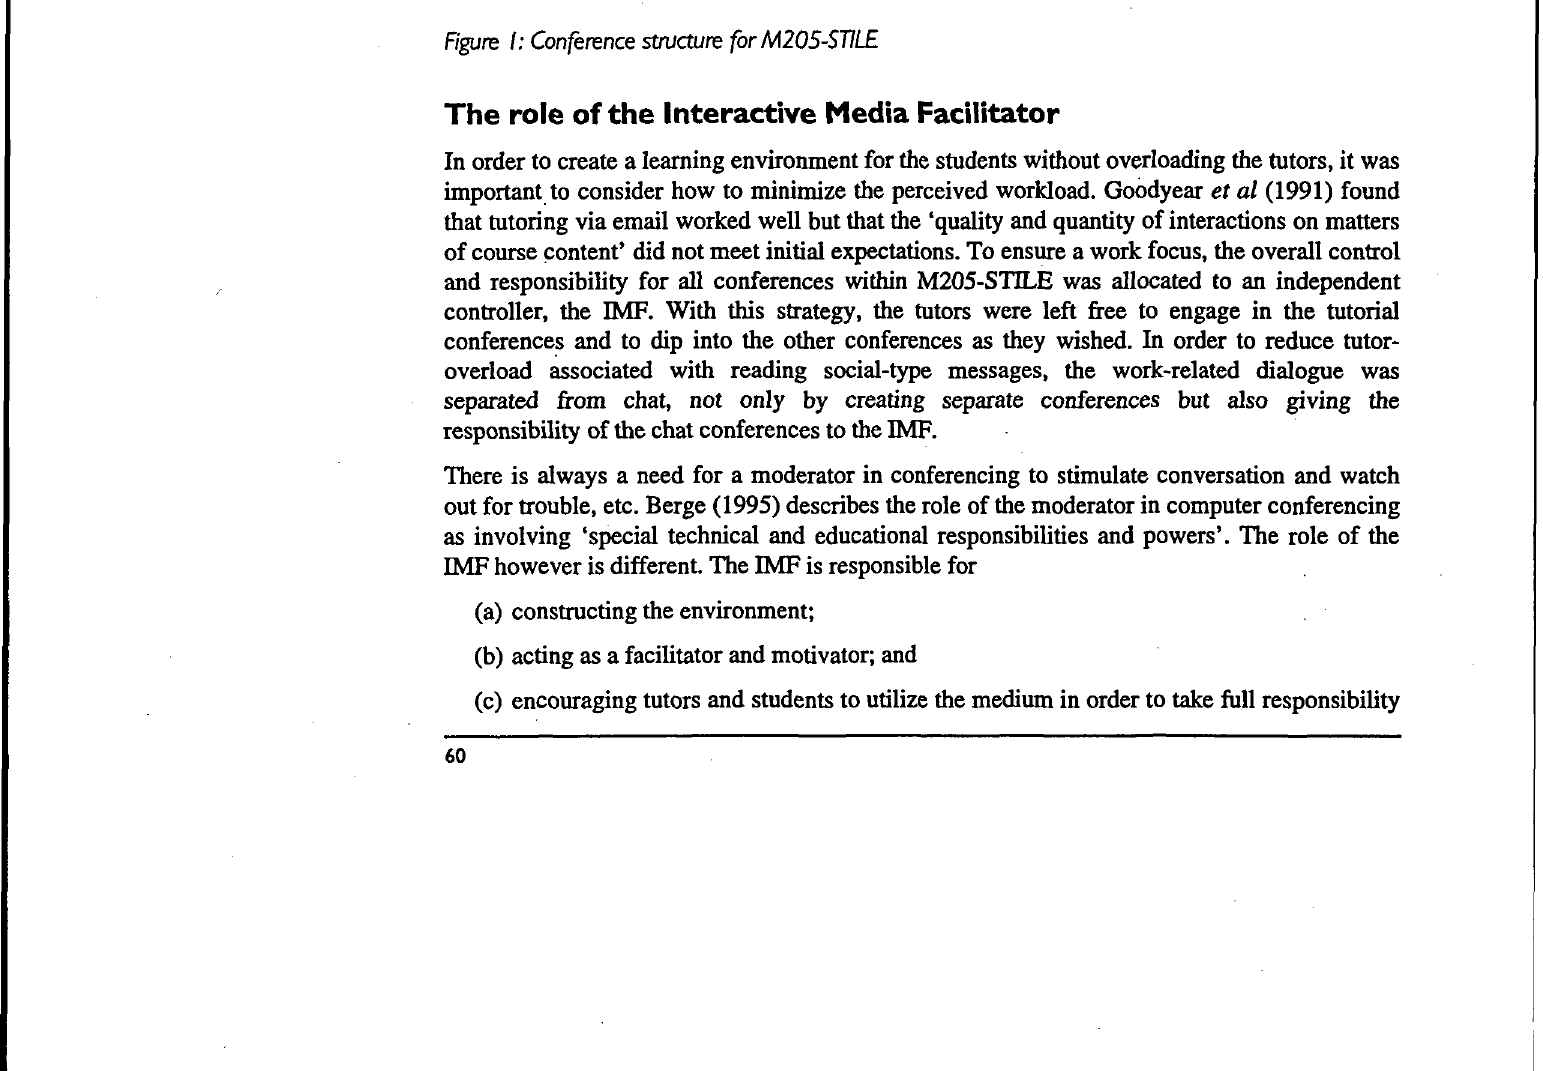
figure /; Conference structure for